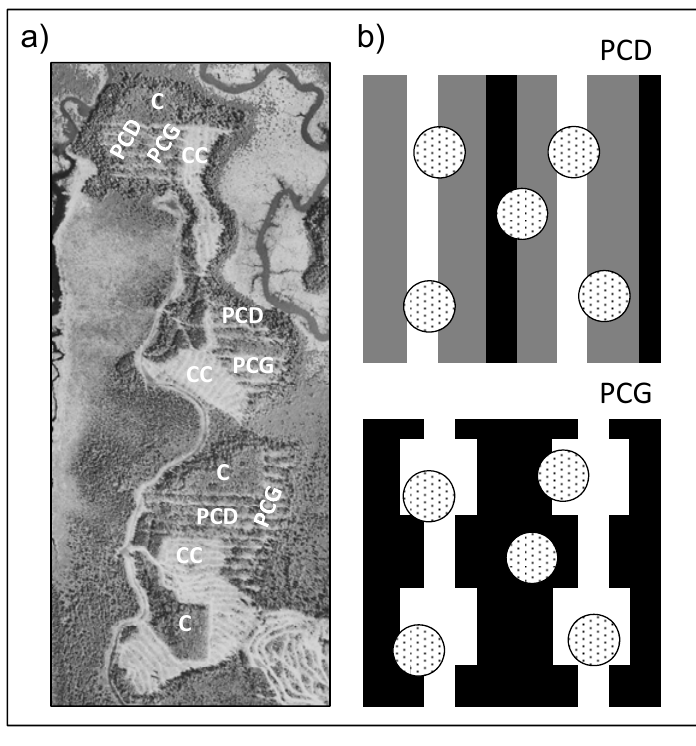
Figure 1. ( a ) Aerial photo of experiment showing treatment layout and ( b ) a schematic representation of partial harvesting treatments according to a dispersed pattern (top) and a gap pattern (bottom). Experimental units were 2–3 ha. The basal area removed was 100% in white areas (hauling trails and gaps), 25% in grey areas and 0% in black areas. Doted circles represent 400m 2 permanent sampling plots within experimental units. C: